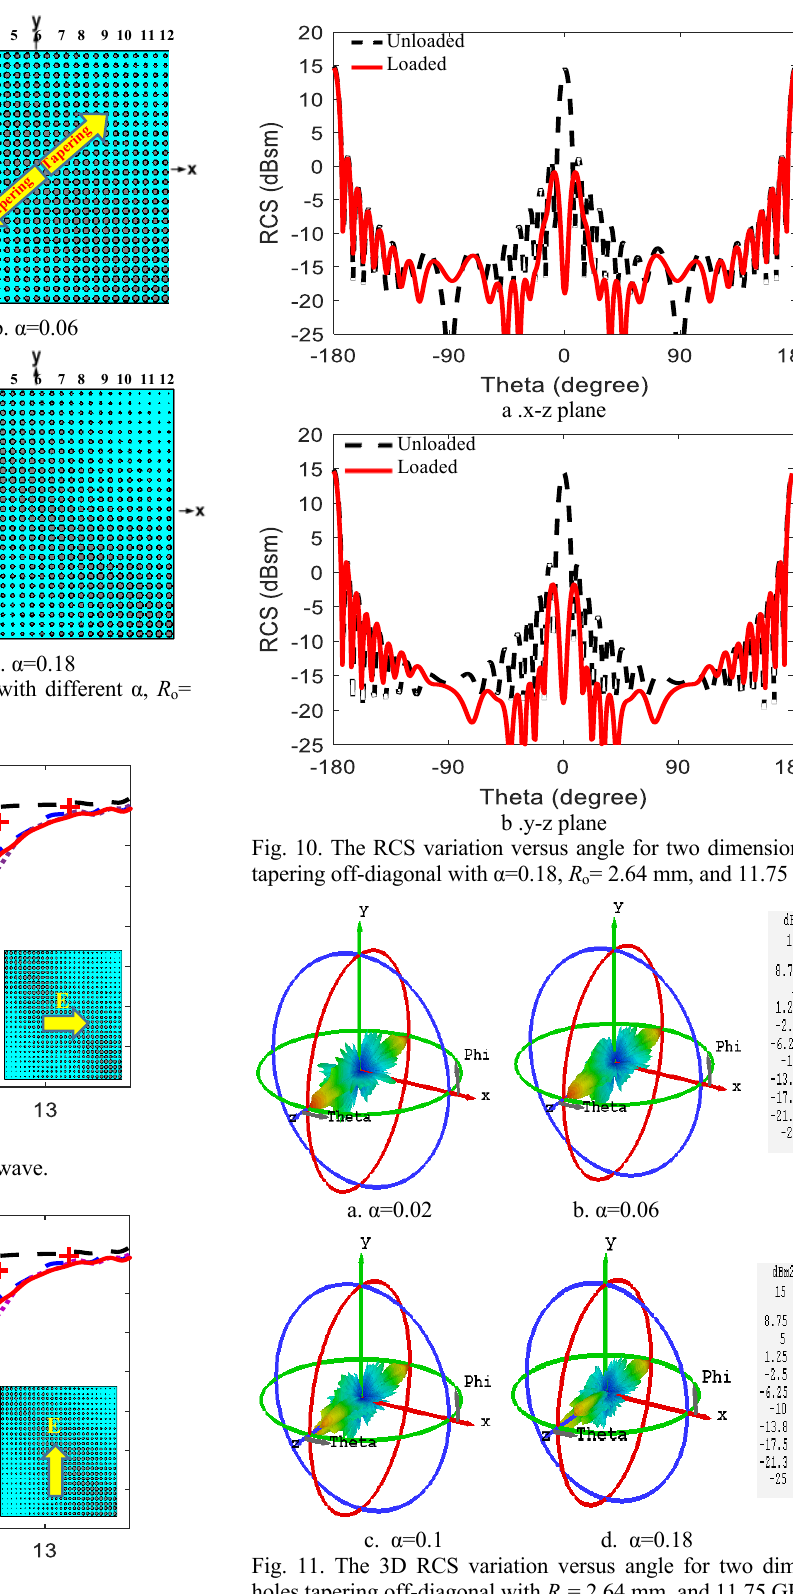
Fig. 11. The 3D RCS variation versus angle for two dimension holes tapering off-diagonal with R o = 2.64 mm, and 11.75